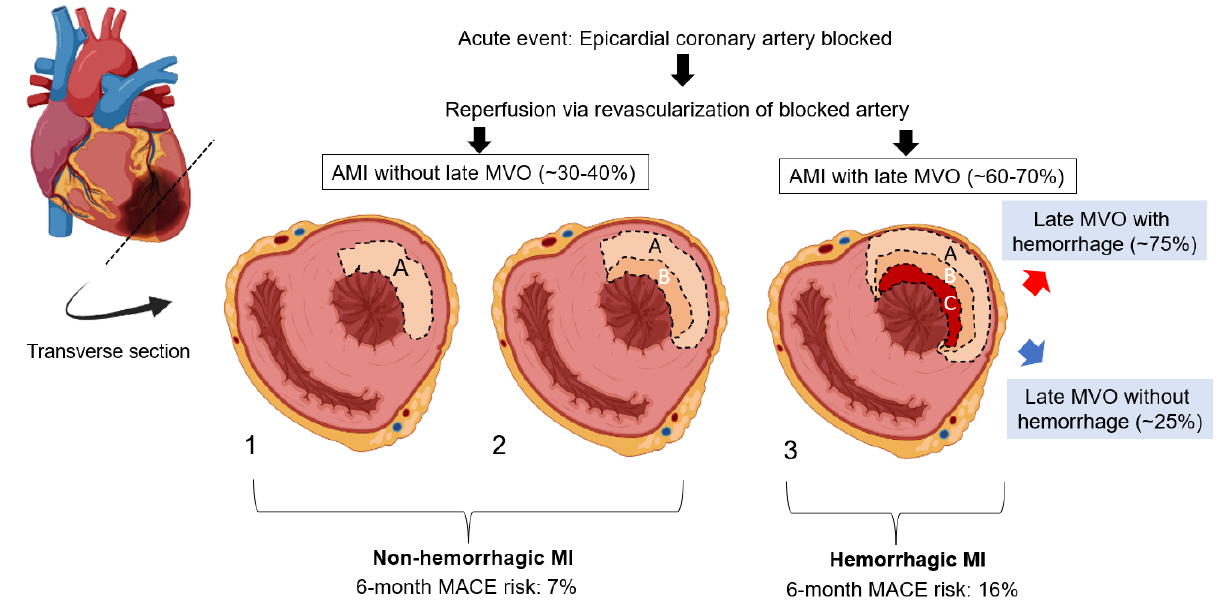
FIGURE 1: Schematic differentiating reperfused acute MIs, fraction of MIs with hemorrhage, and associated MACE risk. Myocyte death proceeds from the subendocardium as a wave of injury with increasing ischemic time with as: 1: Early, reperfusion with myocyte injury only; 2: myocyte injury with mild microvascular obstruction (MVO); 3: myocyte injury with late/persistent MVO. Zones A: myocyte injury only; B: myocyte injury and mild MVO (some slow flow); C: myocyte injury with late MVO (no flow). Intramyocardial hemorrhage occurs in ~75% of the time in Zone C. hMIs have the largest 6-month MACE risk (16% vs. 7%), among all MI types. Figure was generated using